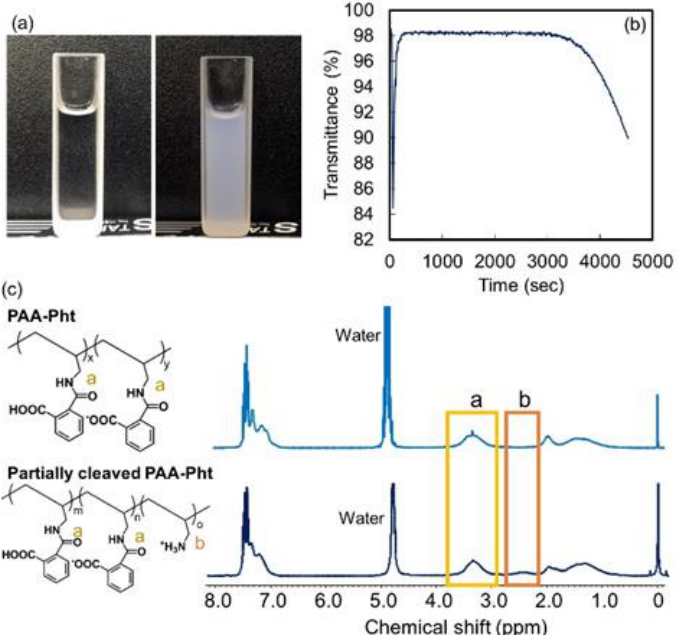
Figure 1. Photographs of PAA-Pht acidic aqueous solution before and after cleavage reaction of amide linkages in the side chain ( a ). Time course of transmittance of PAA-Pht aqueous solution (pH 5.2, 60 °C, and 4.0 mg/mL) ( b ). 1 H-NMR spectra of PAA-Pht before ( c , top) and after ( c , bottom) incubation, where the acid-treatment of PAA-Pht was stopped when the transmittance reached 90%. Polymer: PAA-Pht, Polymer concentration: 4.0 mg/mL, Temperature: 60 °C, pH: 5.2.